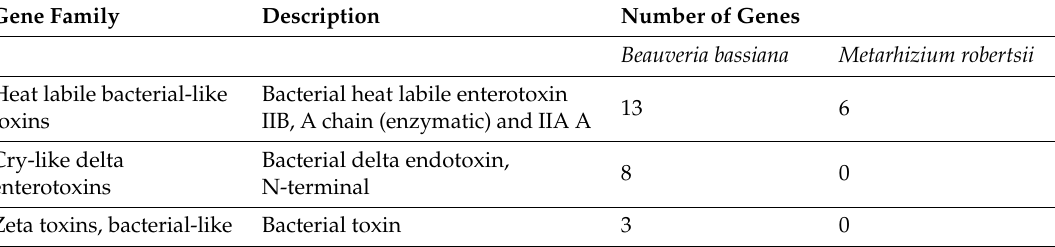
Table 1. Entomopathogenic fungal genes potentially involved in oral infection, according to Xiao et al. (2012). Gene